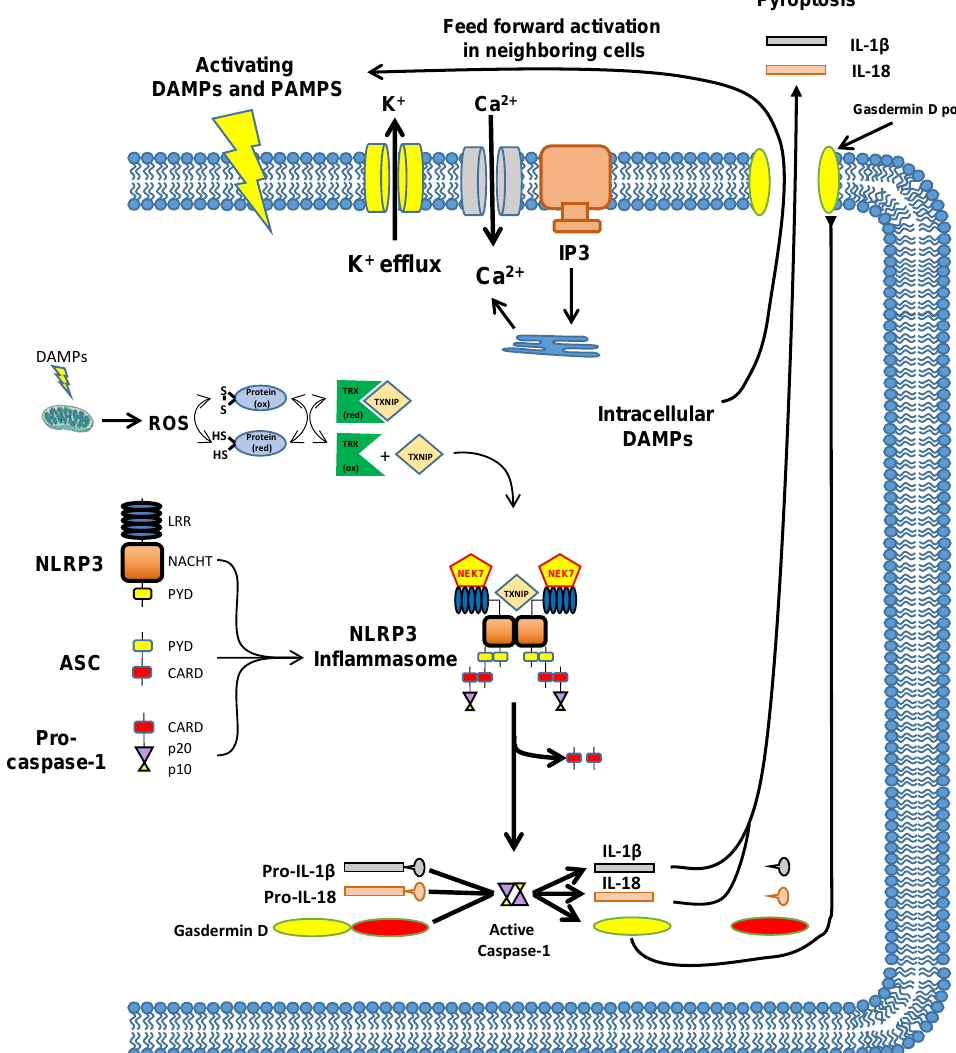
Figure 1. Illustration of the NLRP3 inflammasome, pathways of activation and biochemical mecha- nism of action. As described in the text, the NLRP3 inflammasome can be activated by DAMPS and PAMPS in a multitude of ways, mostly illustrated at the top membrane. DAMPs may also alter release of ROS which free TXNIP to stabilize a developing NLRP3 oligomer. Upon activation, the NLRP3 inflammasome assimilates and activates caspase-1 which cleaves pro-IL- 1β and pro -IL-18 into their active forms. It also cleaves Gasdermin D and the N-terminus forms a pore in the plasma membrane. This pore facilitates release of IL- 1β and IL -18 to act locally and systemically as a pro- inflammatory cytokine. The Gasdermin D pore also releases intracellular DAMPS which can affect neighboring cells to trigger further NLRP3 activation in a feed-forward mechanism. This figured was modified, with permission from Wolters Kluwer, from [81] and incorporates portions from [80] (open access). Once activated, NLRP3 is deubiquitinated, licensing it to form the oligomer. For this, NACHT domains of adjacent NLRP3 molecules associate through homotypic binding, with structural roles for both TXNIP and another protein called never in mitosis gene a- related kinase 7 (NEK7). This facilitates homotypic binding between the pyrin domain on NRP3 and a pyrin domain on an adaptor protein known as apoptosis-associated speck- like protein containing a CARD (ASC). ASC also contains a caspase recruitment domain (CARD) and once ASC is bound to NLRP3 this domain binds a CARD on procaspase-1.